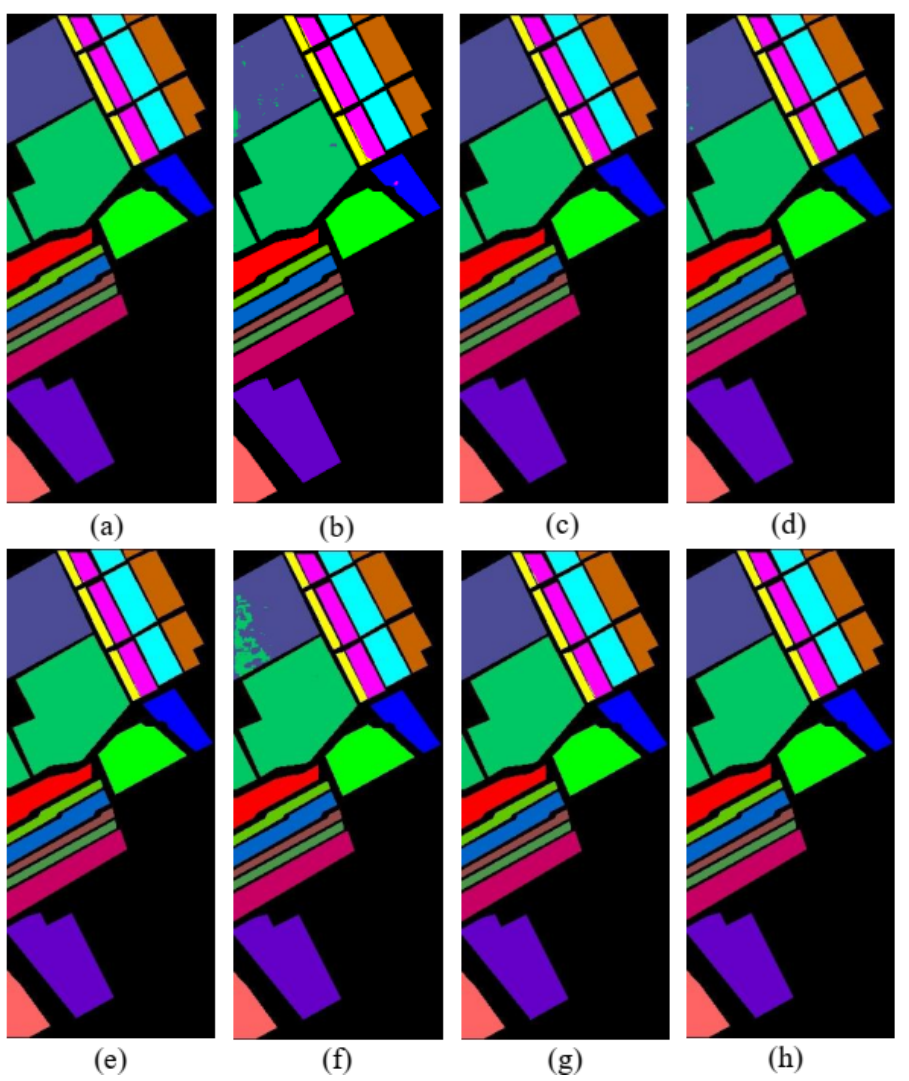
Figure 9. Classification map of various methods for SA ( a ) Ground Truth, ( b ) Resnet, ( c ) 3D-CNN, ( d ) SSRN, ( e ) HybridSN, ( f ) SPRN, ( g ) SSFTT, ( h ) SquconvNet. Table 7. Results of various methods for SA using 10% training data (Highest performance is in Boldface).